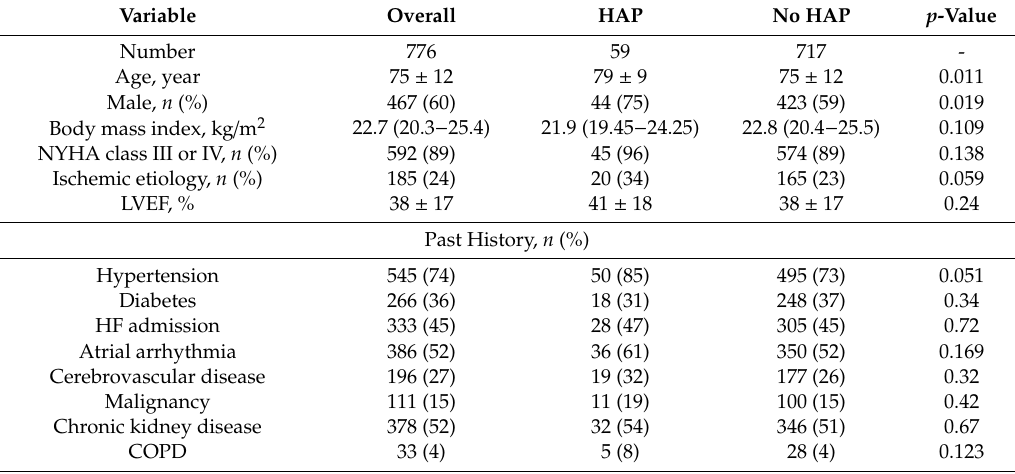
Table 1. Baseline characteristics.